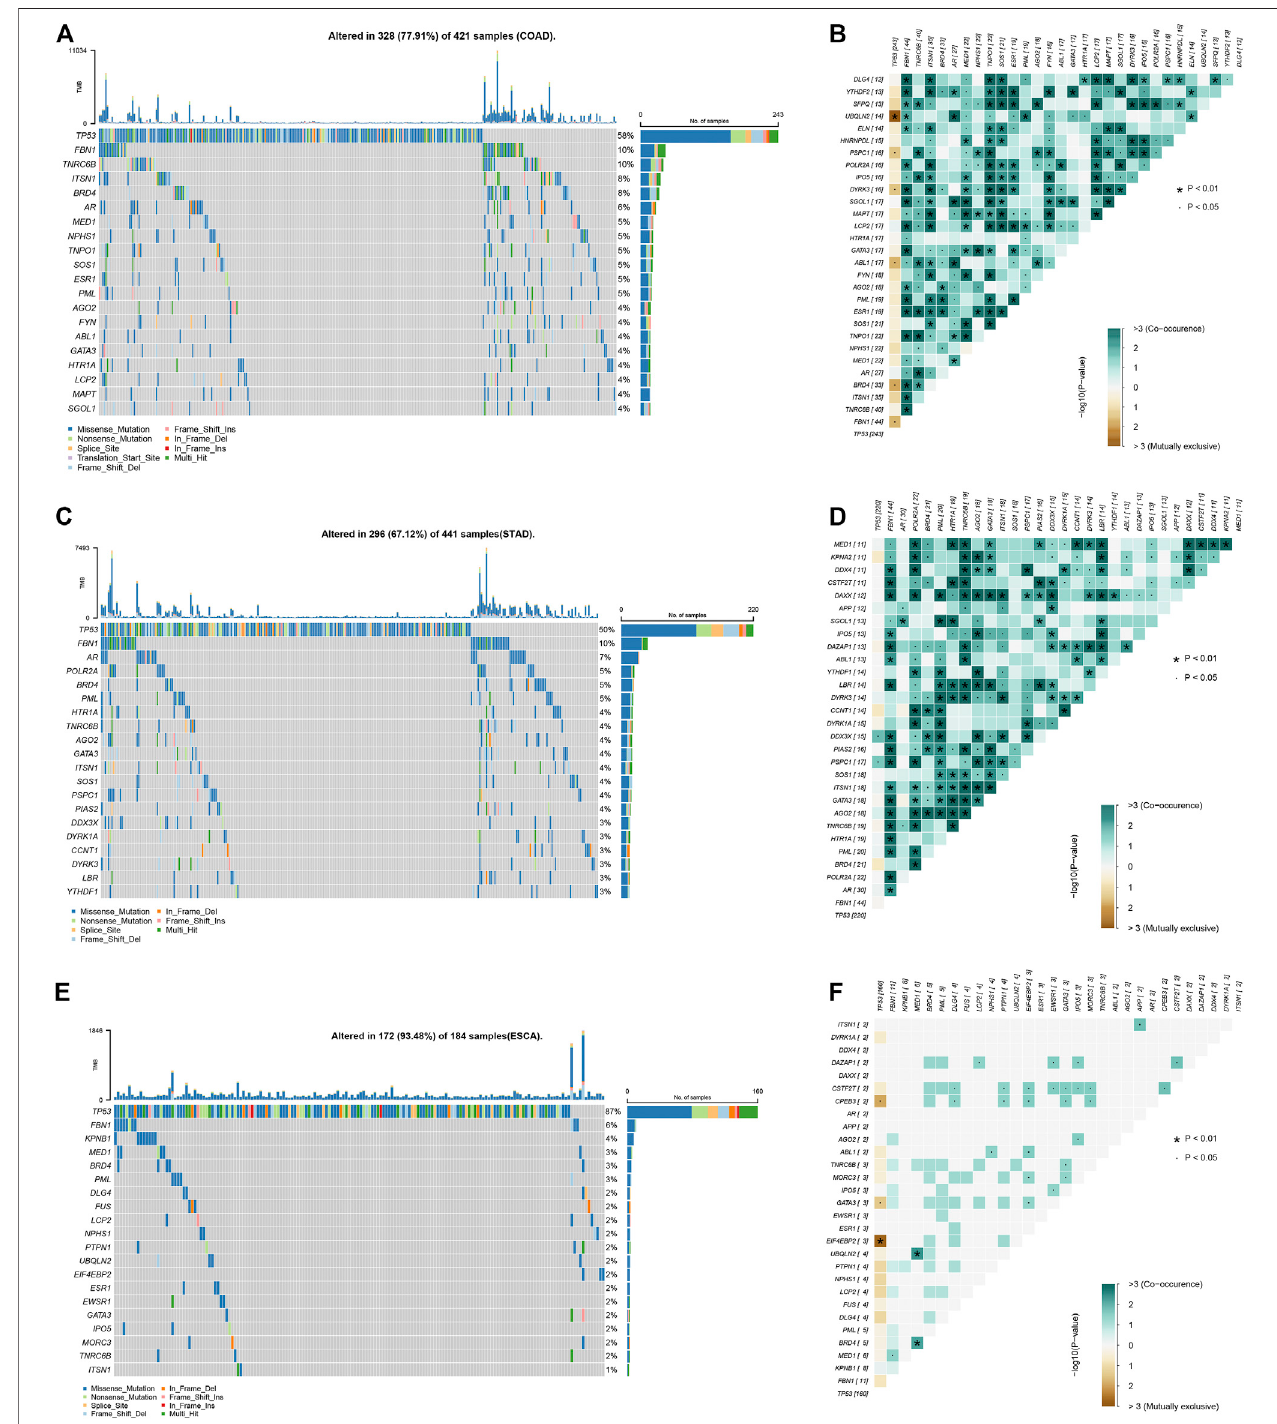
FIGURE 1 | Genetic alterations of LLPS regulators in digestive system neoplasms. (A) The Top LLPS gene alteration of LLPS in COAD. (B) The LLPS gene co- occurrenceandmutualexclusionanalysisinCOAD. (C) TheTopLLPSgenealterationofLLPSinSTAD. (D) TheLLPSgeneco-occurrenceandmutualexclusionanalysis in STAD. (E) The Top LLPS gene alteration of LLPS in ESCA. (F) The LLPS gene co-occurrence and mutual exclusion analysis in ESCA.